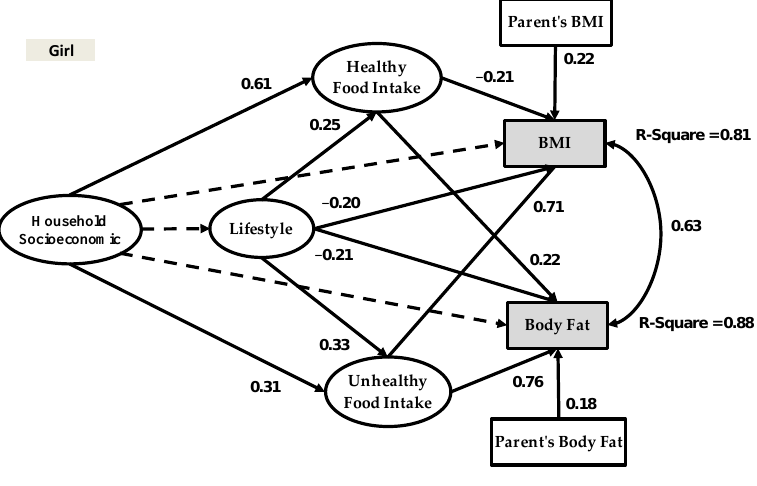
Figure 3. Adolescent girl obesity model.